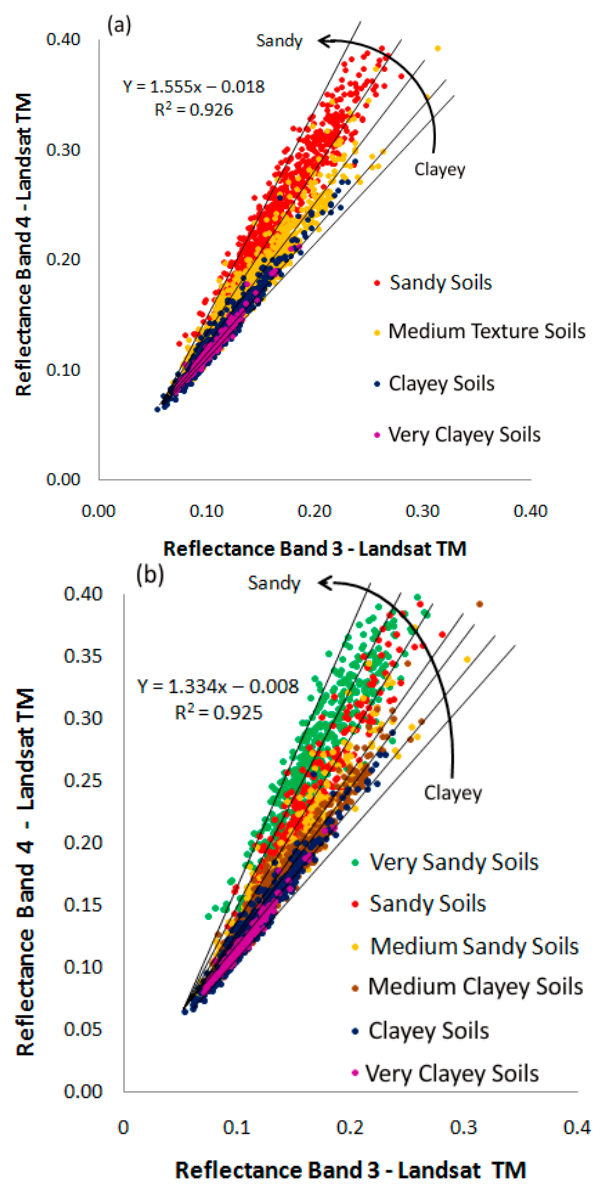
Figure 4. Soil lines obtained for the soils studied through laboratory data simulating TM3 and TM4 bands: ( a ) distribution of textural classes according to the grouping for simplified classification according to SiBCS and ( b ) distribution of textural classes according to the grouping in LBTC.